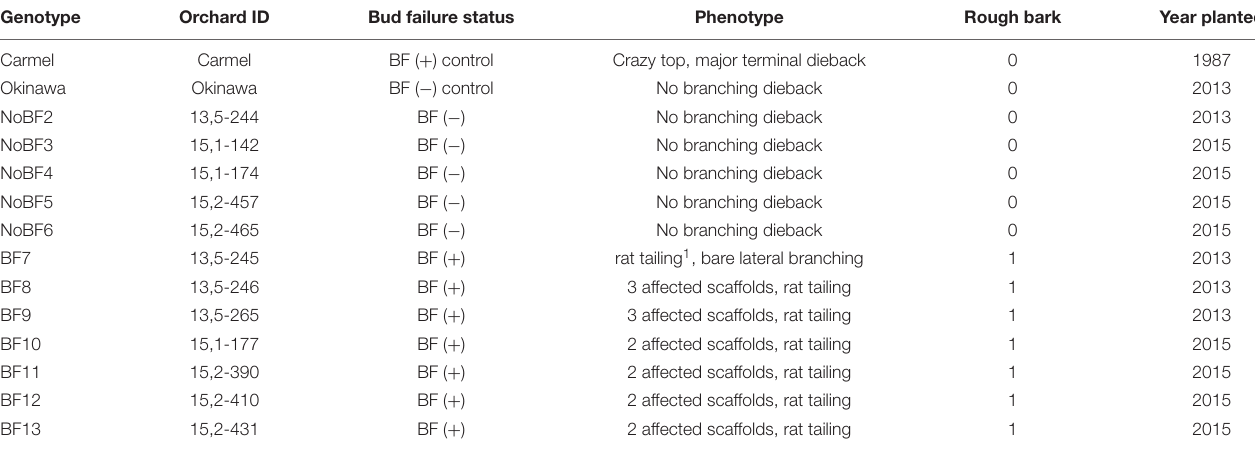
TABLE 1 | Identification of hybrids for RNA sampling including bud failure status and corresponding phenotype as well as year planted.